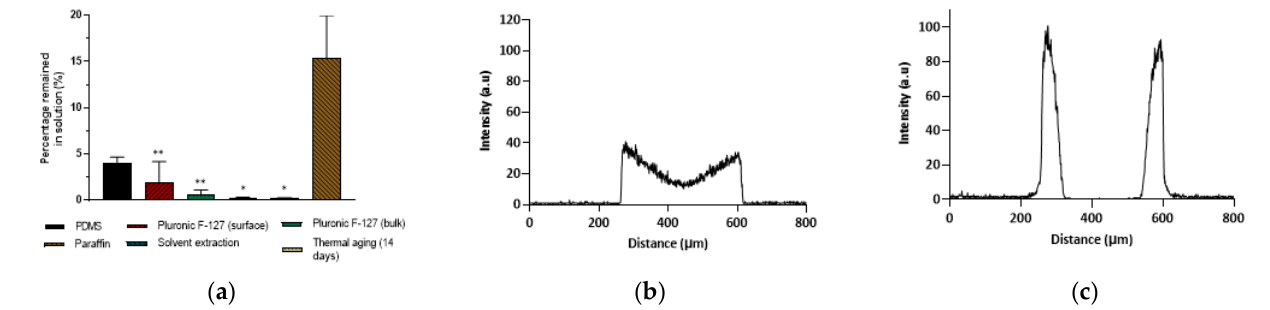
Figure 5. ( a ) Relative concentration ratio (expressed as a percentage) of Nile red that remained in solution following continuous flow through unmodified PDMS microchannels or PDMS microchannels modified with Pluronic ® F127 (surface and bulk modifications), paraffin, thermal aging, and solvent extraction. Values show Mean ± SD from a minimum of two independent experiments (** p < 0.01; * p < 0.05 vs. paraffin modification). ( b , c ) Fluorescence intensity profiles obtained from the confocal micrographs following continuous flow of a 20 µM rhodamine B solution through ( b ) unmodified PDMS microchannels and ( c ) bulk-modified PDMS with sol–gel treatment using tetraethoxysilane (TEOS).